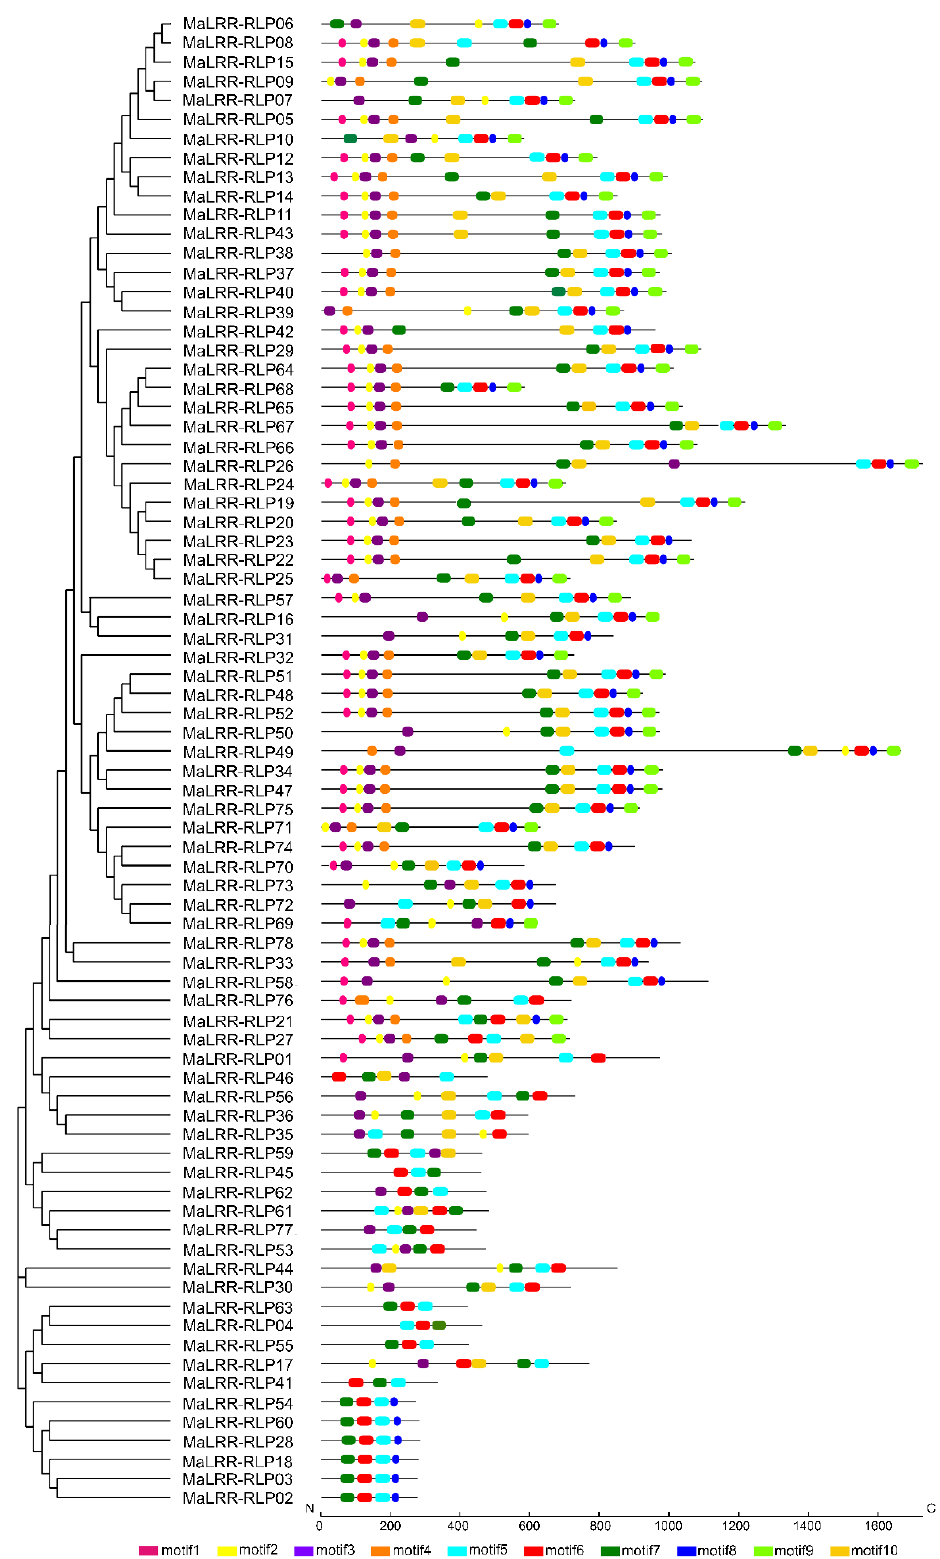
Figure 2. Conserved motifs of banana LRR-RLP proteins. The number of conserved motifs identified by the MEME program was set to 10.